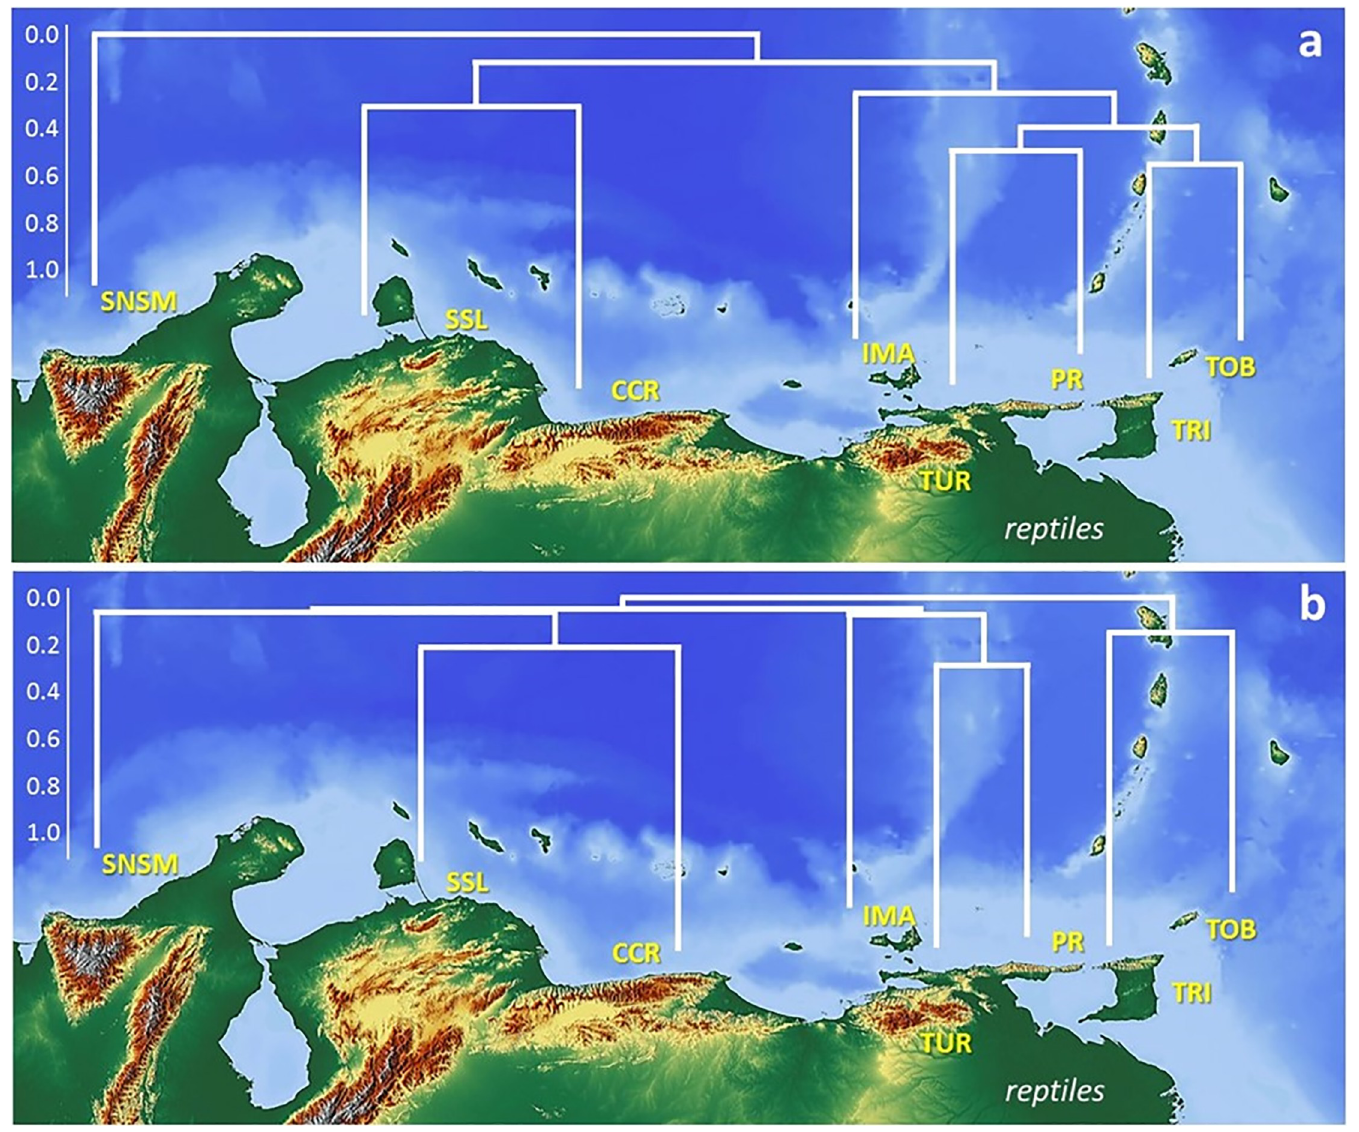
Fig 5. Distribution patterns of reptiles in the different orographic regions. Cluster classification for reptiles (a) found above 200 m in elevation and (b) found exclusively at mid altitude mountain vegetation, based on the UPGMA algorithm and the Jaccard coefficient (cophenetic correlation r = 0.81, and r = 0.84). SNSM (Sierra Nevada de Santa Marta, Colombia), SSL (Sierra de San Luis), CCR (Central Coastal Range), IMA (Isla de Margarita), TUR (Turimiquire Massif), PR (Paria Range), TRI (island of Trinidad), TOB (island of Tobago). Map build with GIS Cloud Apps (www.giscloud.com). Reprinted from Relief Free Map under a CC BY license, with permission from the Open Data Commons Open Database License (ODbL) by the OpenStreetMap Foundation (OSMF), original copyright OpenStreetMap 1